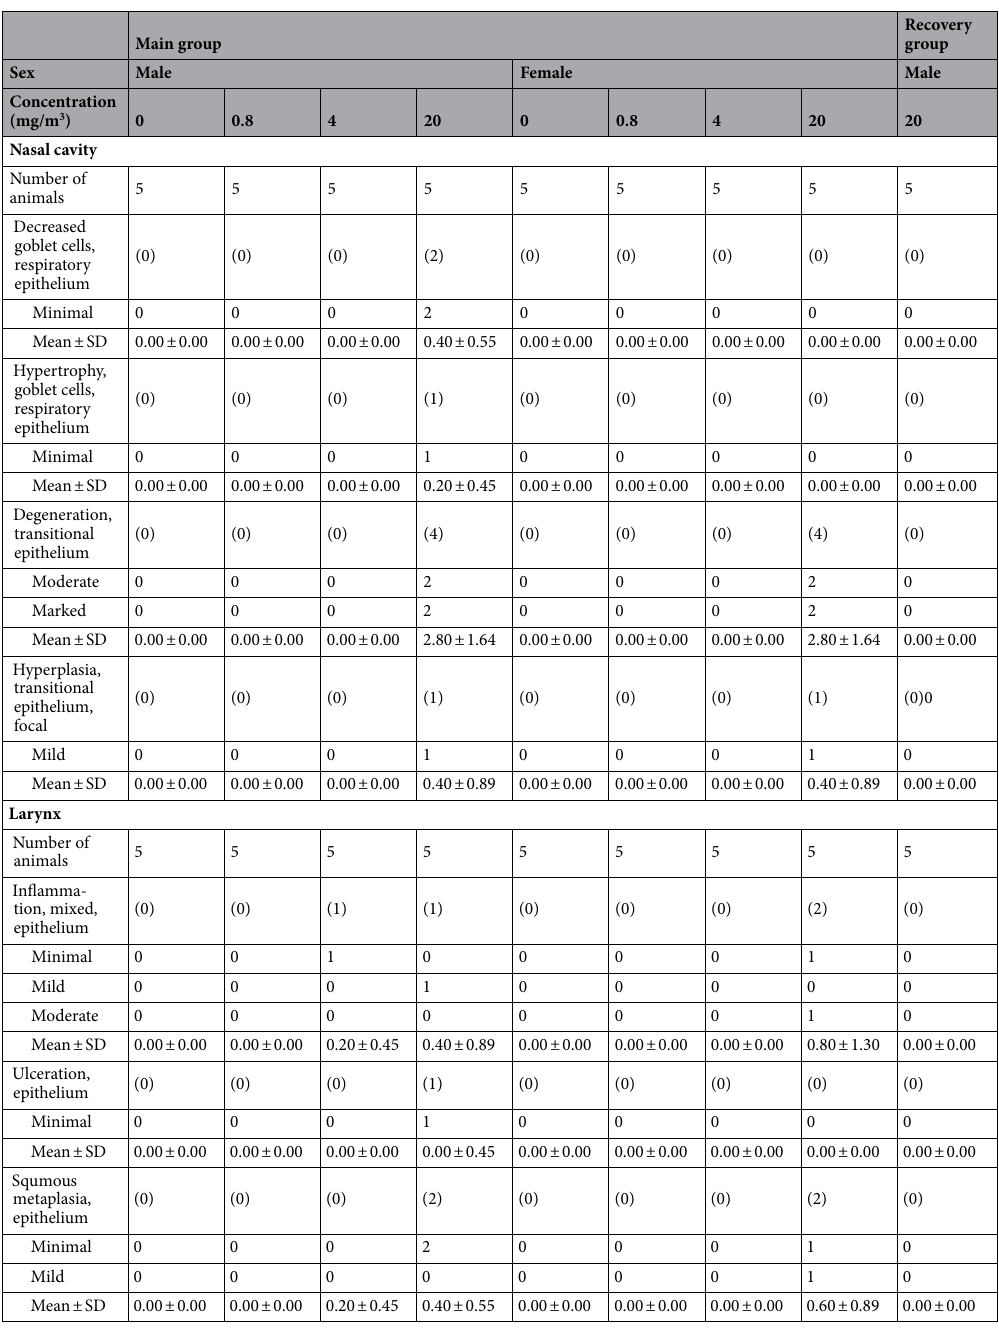
Table 4. Histopathological assessment of the nasal cavity tissues and larynix in rats. 0: unremarkable = no presence of histopathologic lesion; 1: minimal = lesions involving < 10% of the tissue of each organ; 2: mild = lesions involving < 10–30% of the tissue of each organ; 3: moderate = lesions involving < 30–50% of the tissue of each organ; 4: marked = lesions involving < 50–70% of the tissue of each organ; 5: severe = lesions involving > 70% of the tissue of each